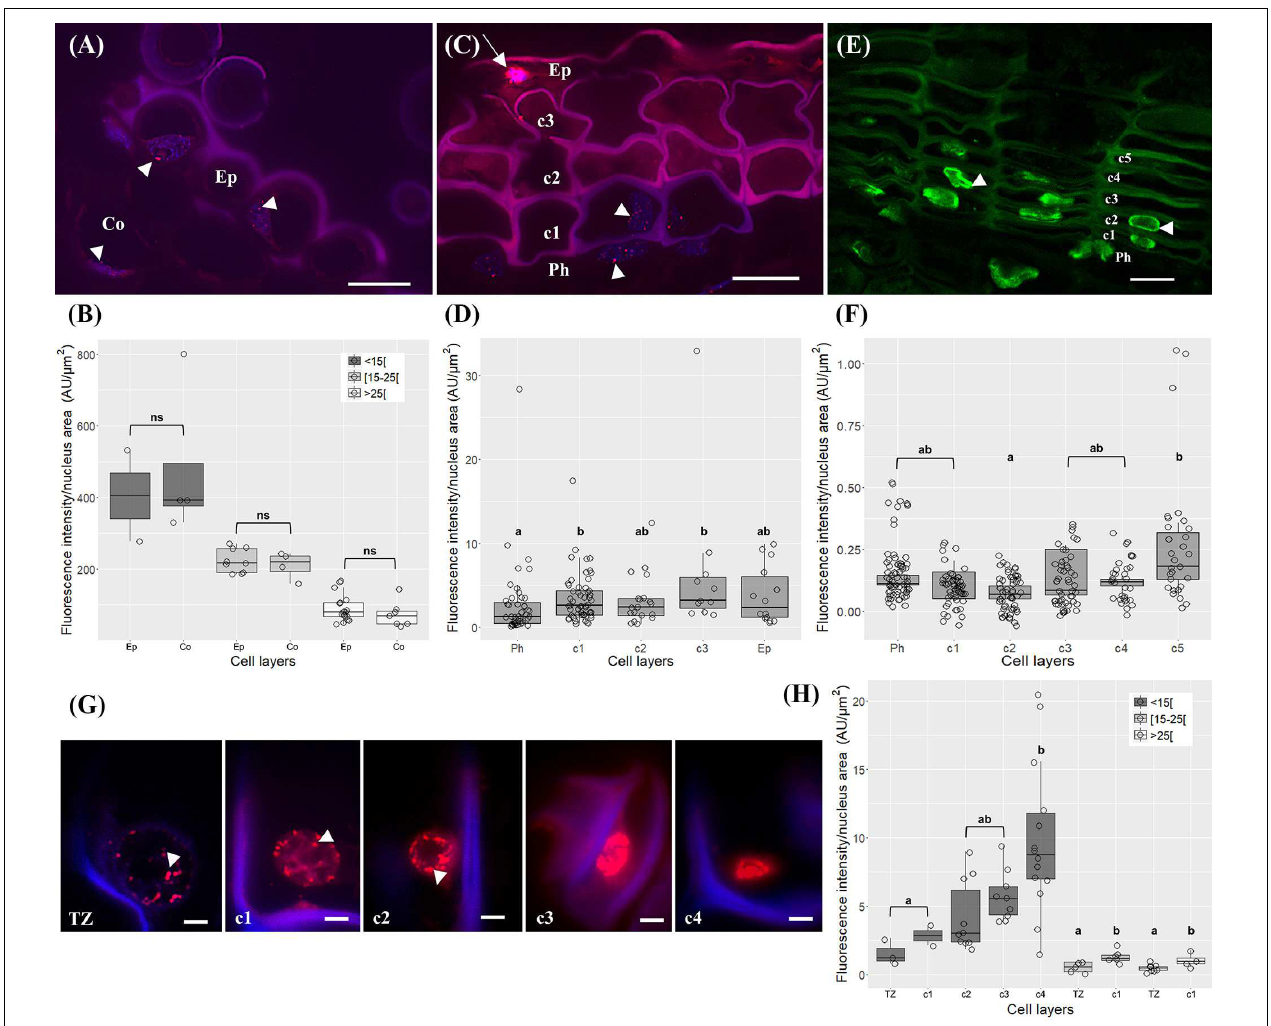
FIGURE 4 | Immunolocalization of 5-methylcytosine (5-mC) in periderms from young sprigs and traumatic periderms. (A) Herbaceous sprigs nuclei show discrete 5-mC signals distributed in small spots all over the chromatin in cortex and epidermis, with similar intensity level in all the nuclei area classes [ < 15[, [15;25[, and [ < 25[ µ m 2 (B) . (C) Nuclei of one-year old sprigs show 5-mC signals dispersed throughout the nucleus in all cork cell layers c1, c2, c3, c4; an epidermal nucleus shows high levels of DNA methylation (arrow); (D) all cork cells show significant higher intensity levels of 5-mC when compared with phellogen, except for c2 and a 2.5-fold increase is detected from the phellogen to the older cork cell layer (c3). (E) Nuclei of three-year-old sprigs show highest intensity of 5-mC signals at the nuclear periphery with a significant increase from c2 to c5 (F) . (G) Nuclei from traumatic periderms show increase and change in distribution: the nuclei from the tear zone and the most recently formed cork cell layer (c1) display slight dispersed 5-mC signals, that become stronger at the nuclear periphery in older cork cell layers (c2, c3, and c4). (H) A significant and pronounced increase in the 5-mC levels is noticed from the tear zone to the older cork living cell layer (c4) in nuclei with areas less than 15 µ m 2 . Boxplots represent minimum fluorescence intensity/nucleus area, first quartile (bottom of box), median, third quartile (top of box), and maximum. The distribution of every individual measurement is represented by jittered dots. Arrowheads indicate 5-mC signals. Similar small letters indicate no significant differences. DNA was counterstained with DAPI. Bars in ( A,C,E ) = 10 µ m and in (G) = 2 µ m. Ph, phellogen; Ep, epidermis; Co, cortex; Tz, tear